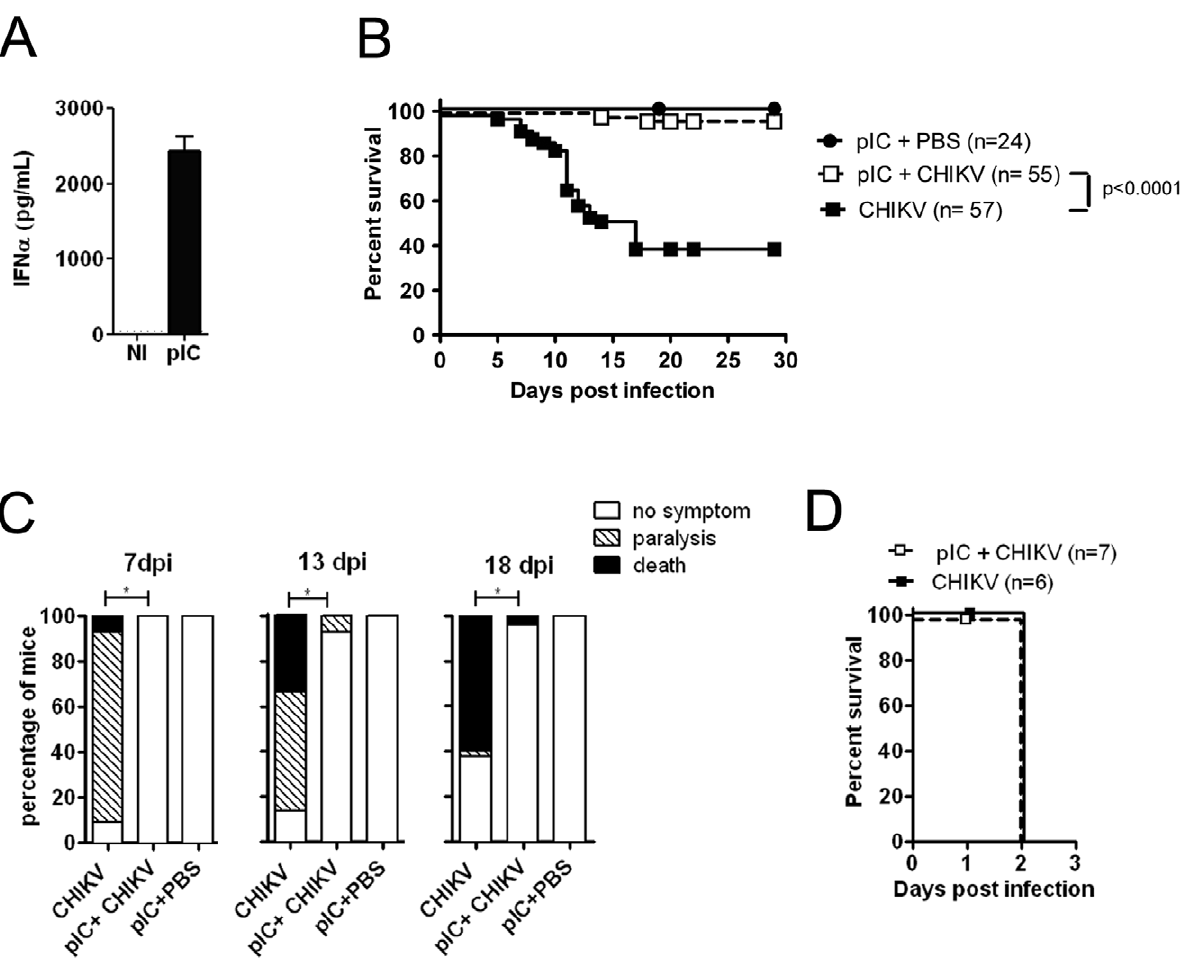
Figure 5. Adjuvant induced type I IFN production protects neonates from CHIKV infection. Mice (8 days of age) were injected i.p. with 25 m g of pIC and 24 hours later mice were infected s.c. in the right flank with CHIKV. ( A ) IFN a levels produced in the serum of neonatal mice 7 hours post injection with 25 m g pIC. ( B ) Survival was monitored daily for four weeks and displayed as Kaplan-Meier survival curves. ( C ) Mice were scored for clinical signs of disease on days 7, 13 and 18 post-infection as discussed in materials and methods. ( D ) IFNAR 2 / 2 mice (8 days of age) were injected i.p. with 25 m g of pIC and 24 hours later mice were infected with CHIKV s.c. Survival was monitored daily.